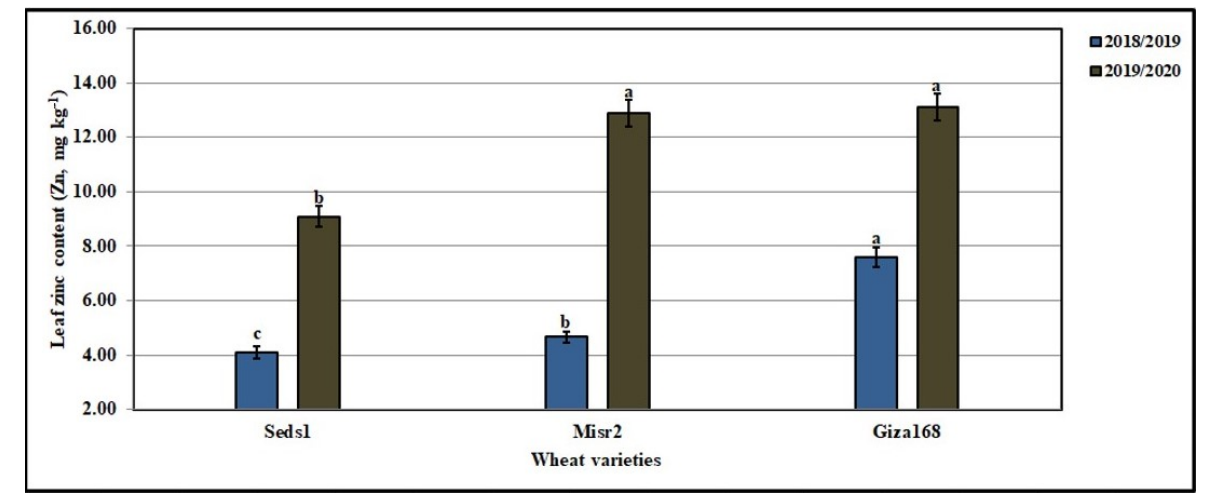
Figure 31. Influence of wheat varieties on leaf zinc contents (Zn, mg kg − 1 ) in clay loam soil in 2018/2019 and 2019/2020 seasons. Bars in the same years with a different letter indicate significant differences between treatments at p ≤ 0.01. HS 1, HS 2 , HS 3 represent HS applied as foliar spray at 1.0, 2.0, 4.0 g L − 1 , respectively, HS 4 , HS 5 , HS 6 represent HS applied as soil application at 5.04, 7.56, 10.08 kg ha − 1 .